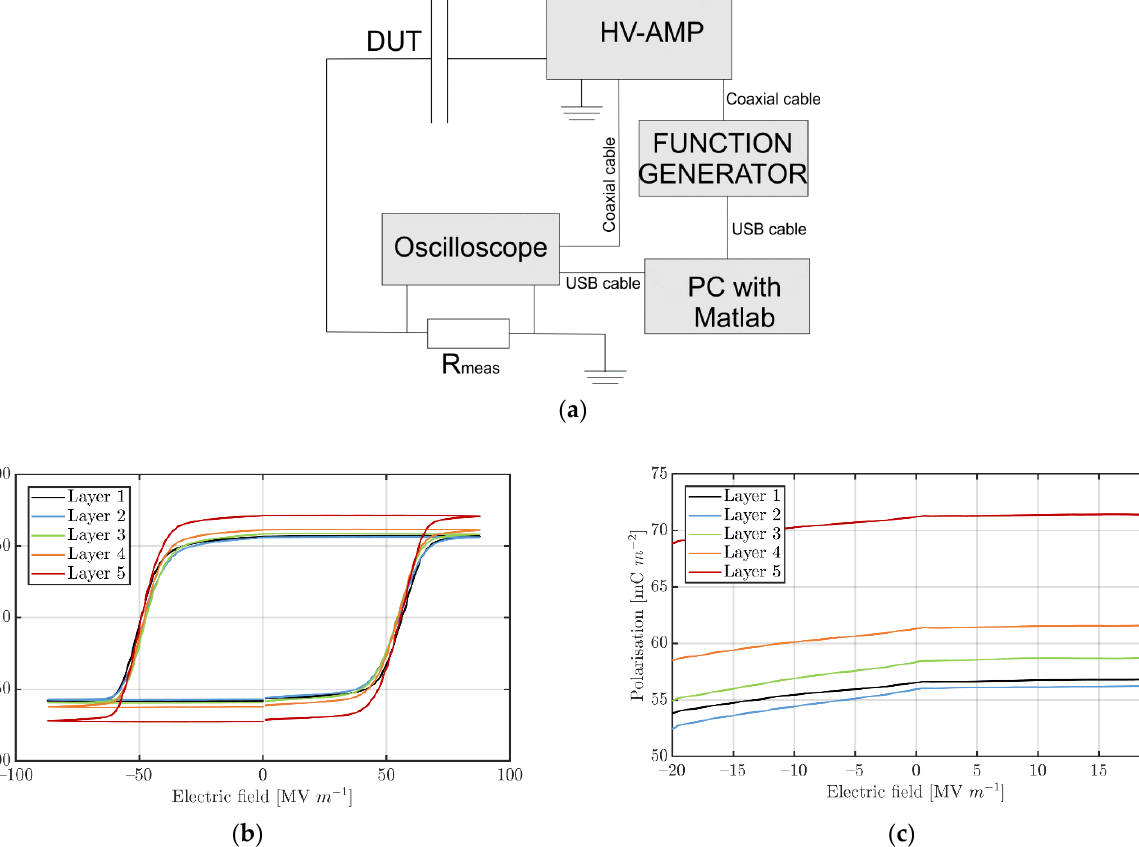
Figure 2. ( a ) Schema of the poling set-up. P-E-Loops of ( b ) each individual layer within a multilayer stack device with five active P(VDF-TrFE) layers. ( c ) Detail of the P-E-Loops showing the layer-to- layer difference in remanent polarisation more precisely.